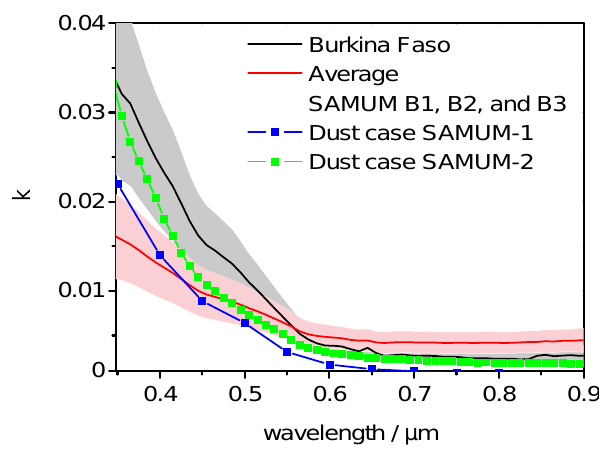
Fig. 12. Retrieved k spectrum for the Burkina Faso dust probe and averaged k spectrum for the three SAMUM B1, B2, and B3 dust samples from this study (the shaded areas represent the errors from Table 5) in comparison with imaginary parts of refractive indices derived during the SAMUM-1 and SAMUM-2 field campaigns for typical dust cases; see Fig. 8 in M¨uller et al.